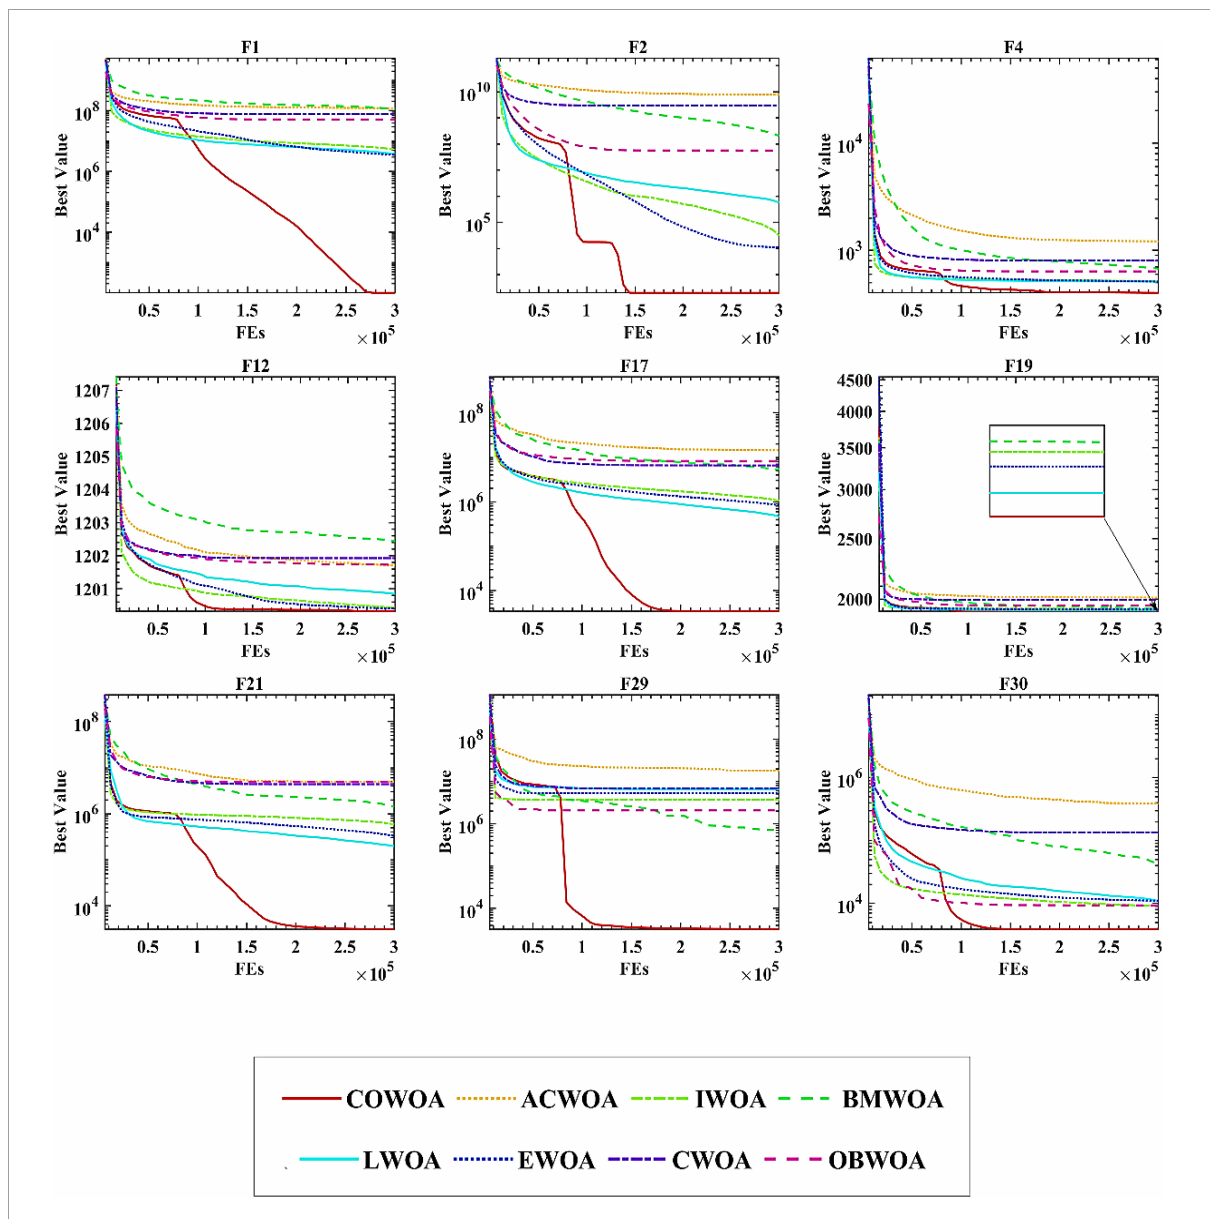
FIGURE8 Convergence curves of COWOA with the WOA